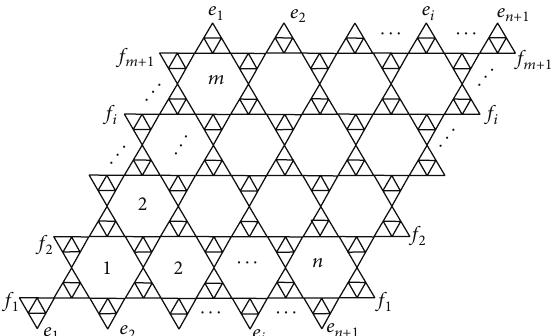
Figure 2: The TKL 𝑡 (𝑚, 𝑛) lattice with toroidal boundary condition